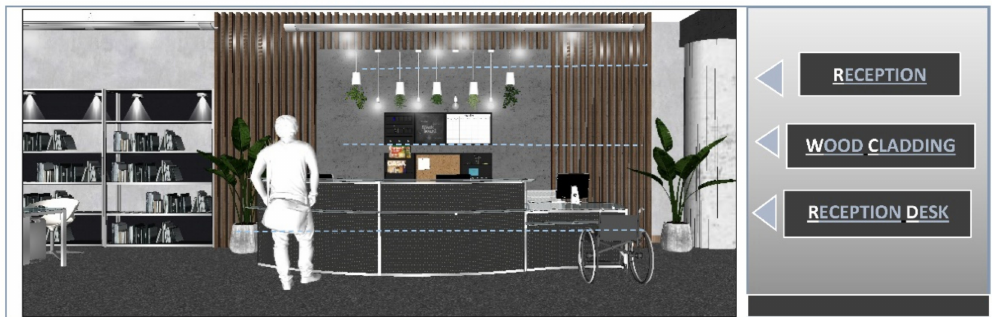
Figure 8. The proposed space for the design of the reception space in the library.